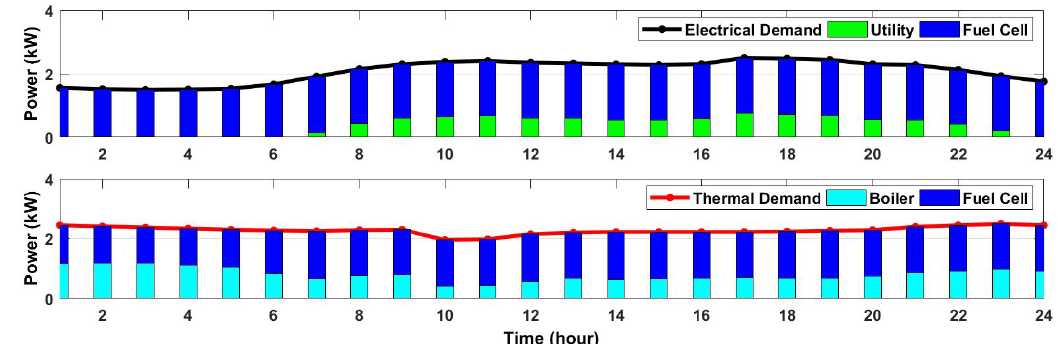
Figure 7. Case 2: Electrical and thermal demands after adding the fuel